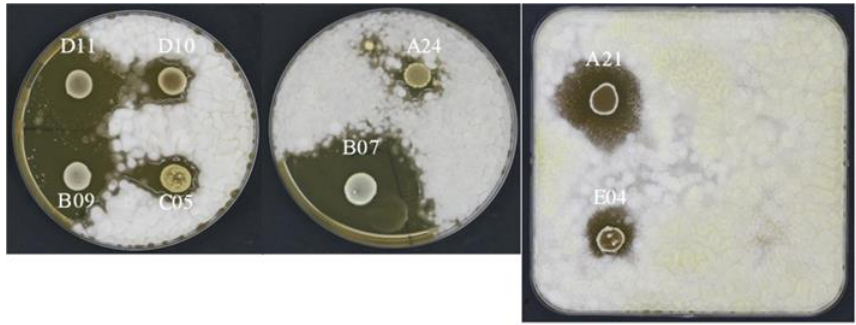
Figure 5. Examples of halos of inhibition against Aspergillus flavus .